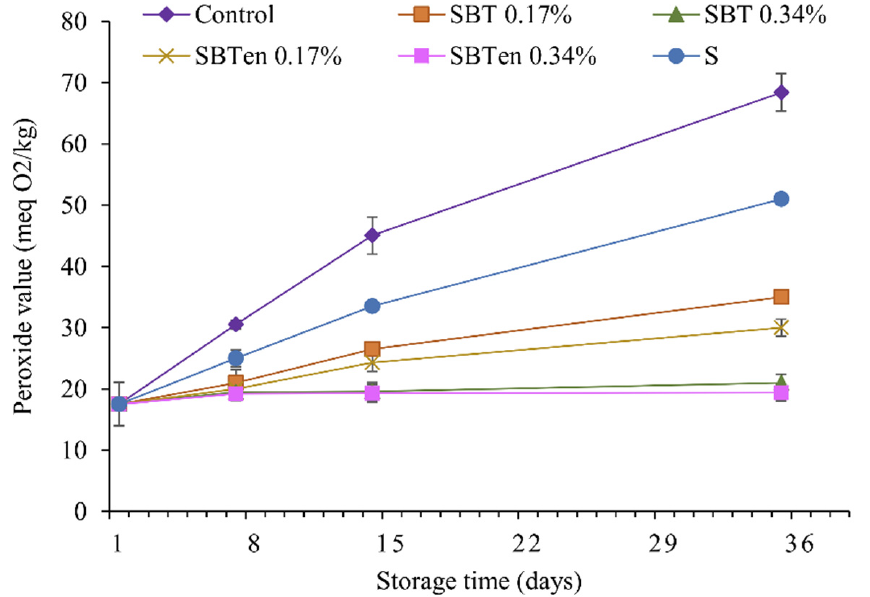
Figure 6. The changes of peroxide value of soybean oil during 35 days of storage at 27 °C, open glass vial (control) and starch films without and with incorporating free or encapsulated SBT extracts at 0.17% or 0.34%.